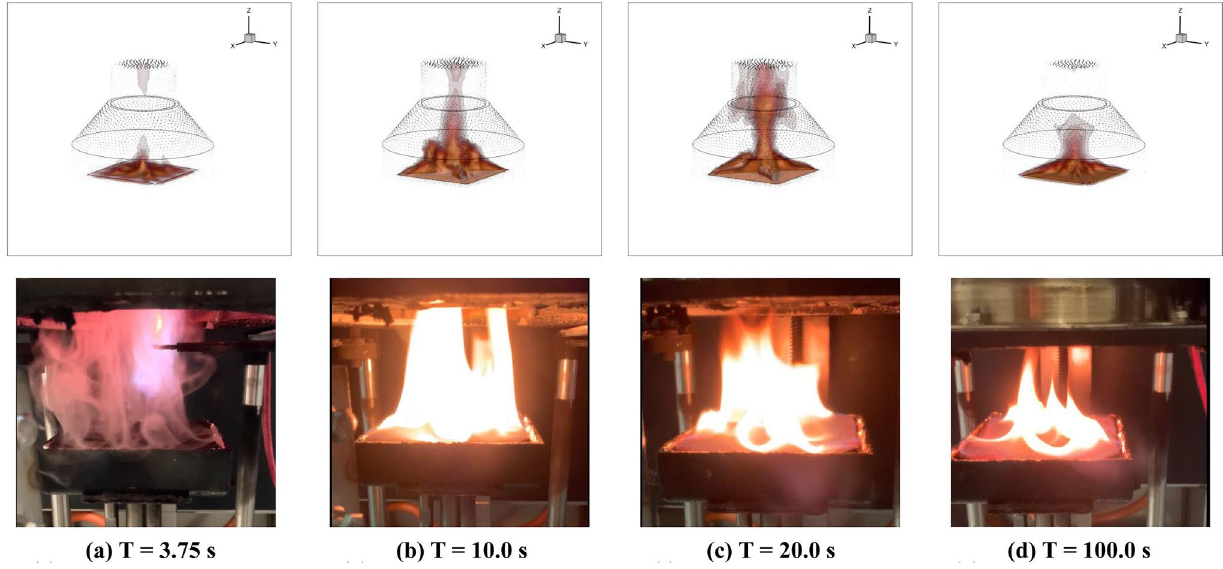
2 cone calorimeter simulation and experimental